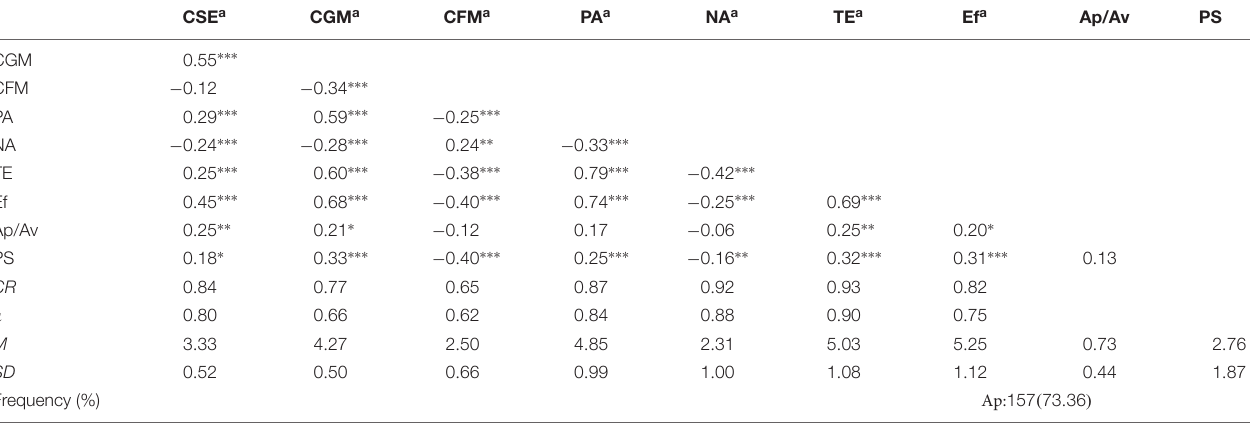
TABLE 3 | Descriptive statistics, reliability coefficients, and correlations for Study 2.